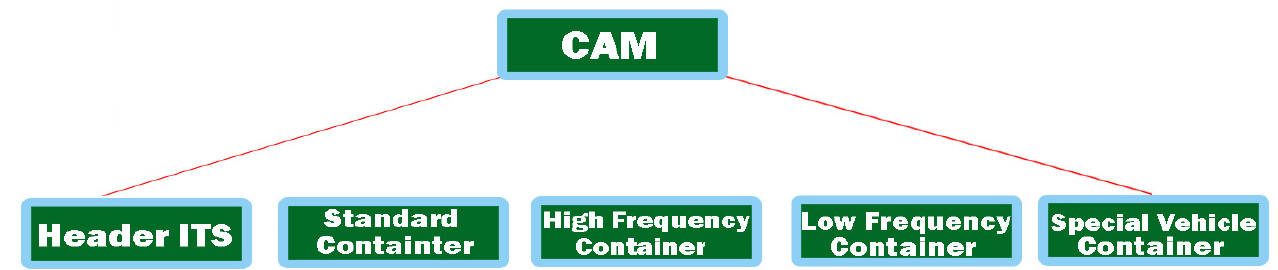
Figure 3. General structure of CAM messages.